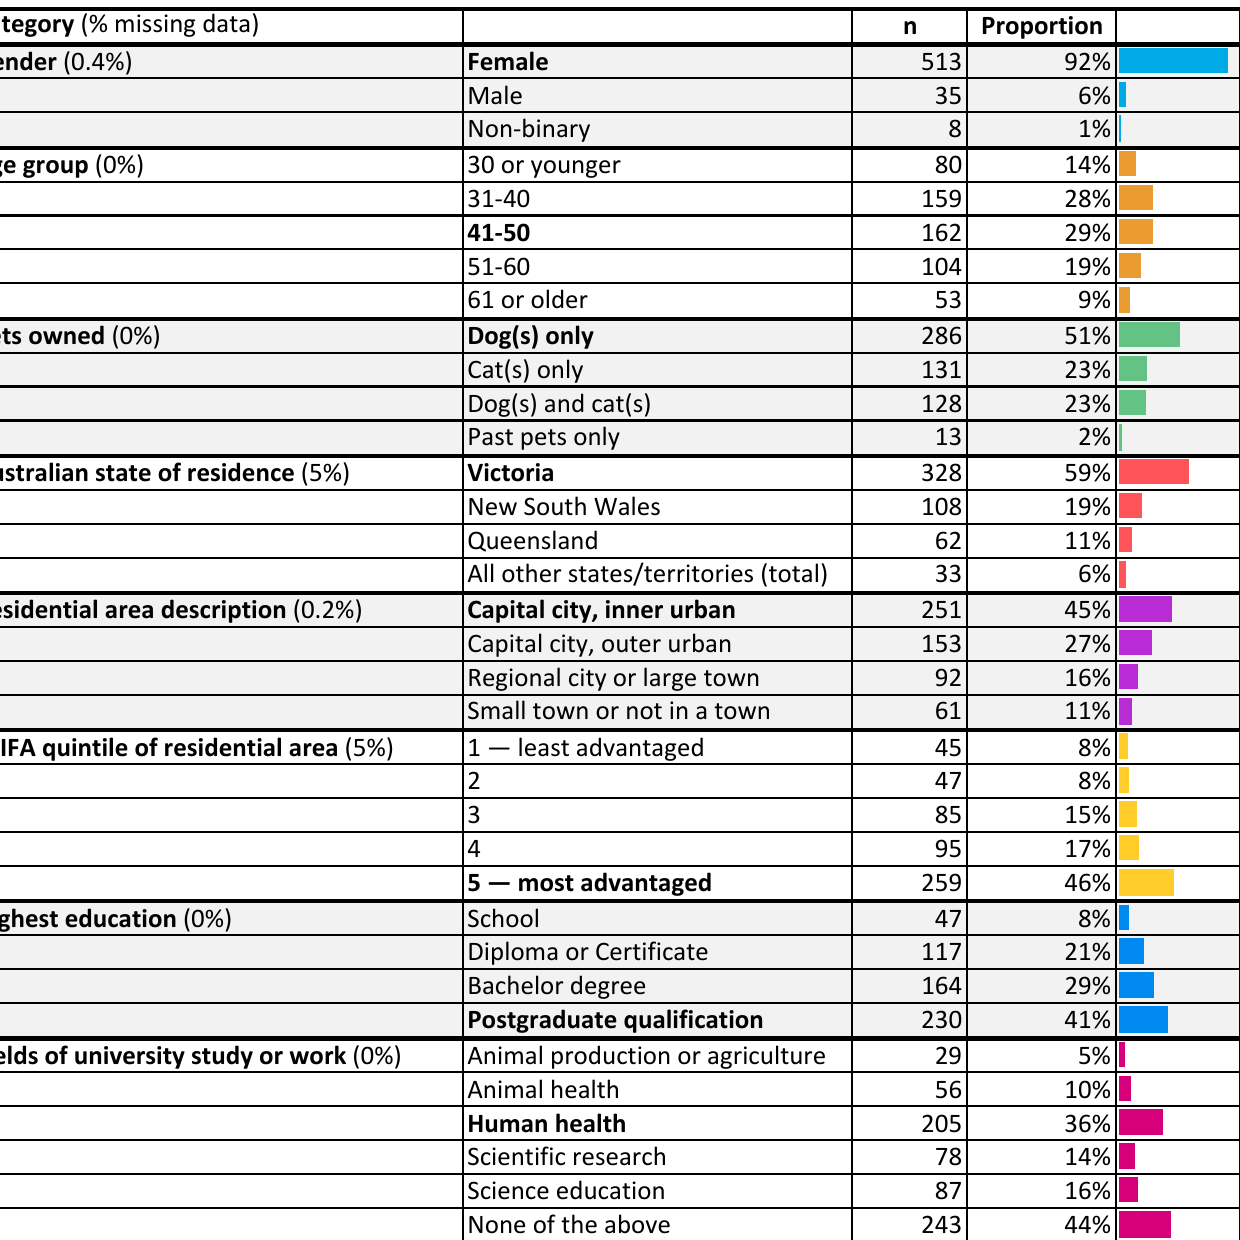
Figure 1. Demographics of the 558 included survey participants (excluding insufficiently complete